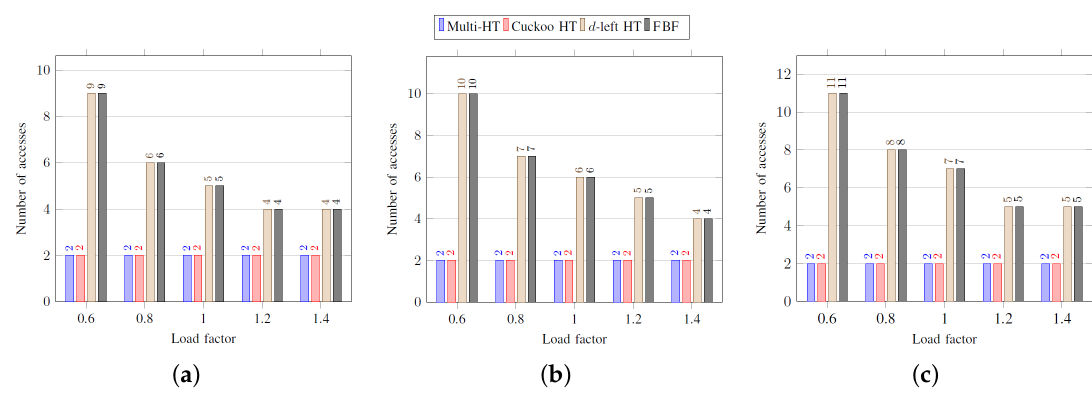
Figure 6. Worst-case number of accesses in a search: ( a ) 8k; ( b ) 32k; ( c )